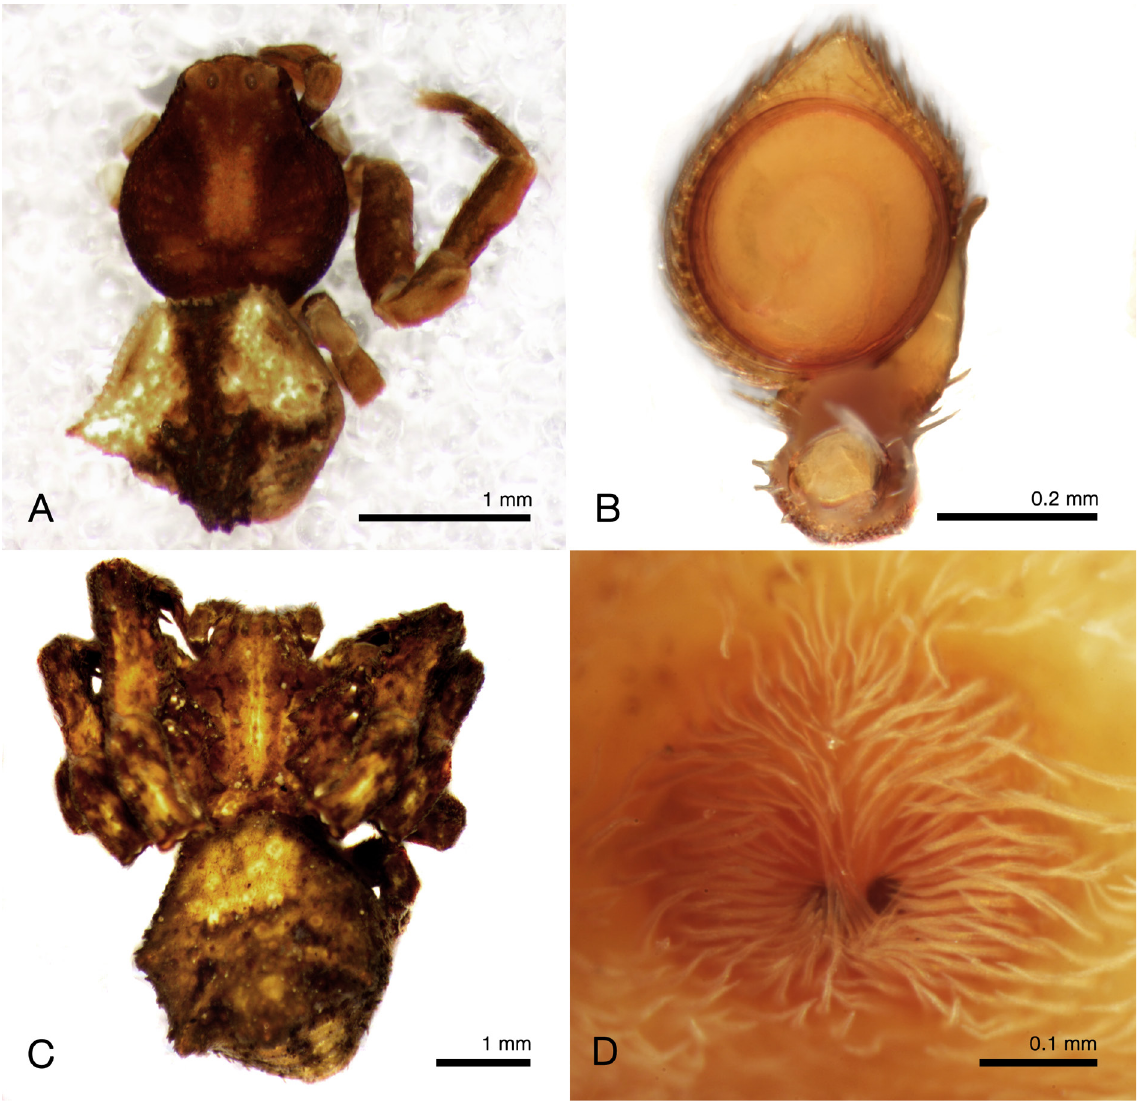
Fig. 26. Syntypes of Stephanopis salobrensis Mello-Leitão, 1929 (MNHN 3973). A . Male habitus, dorsal view. B . Left palp, ventral view. C . Female habitus, dorsal view. D . Epigynal plate, ventral